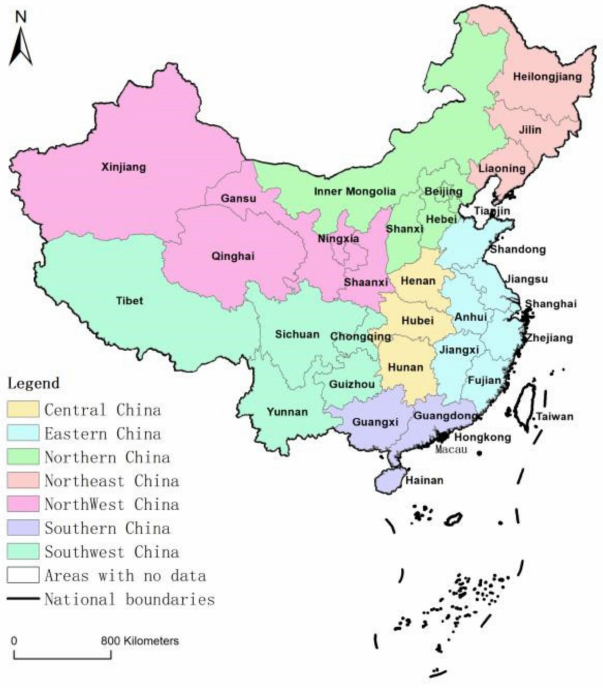
Figure 1. Agglomeration of provincial level administrative